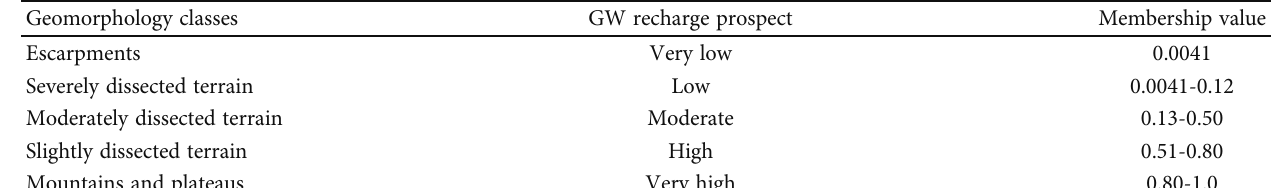
Table 8: Geomorphology classes, membership value, and distribution.